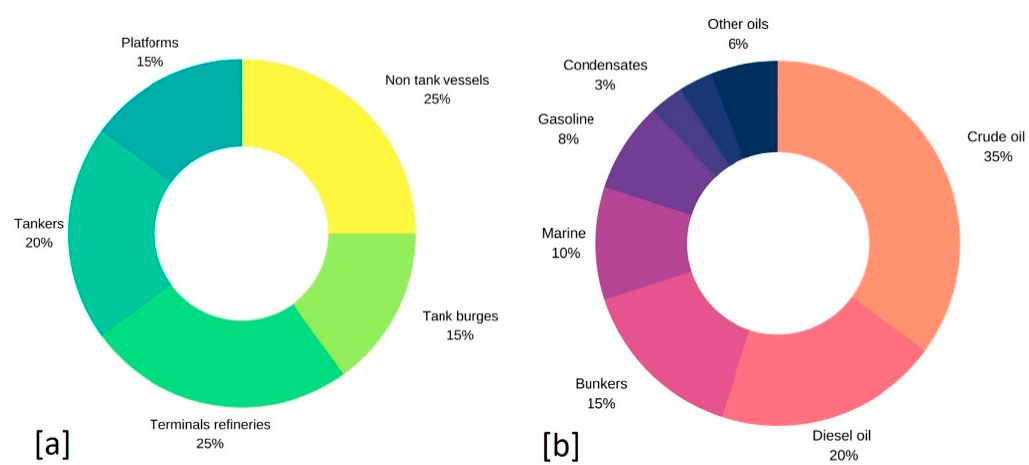
Figure 1. ( a ) Percentage (%) of origin of oil spills in the water. ( b ) Percentage (%) of oil types (authors’ own study, data collected from [2]).